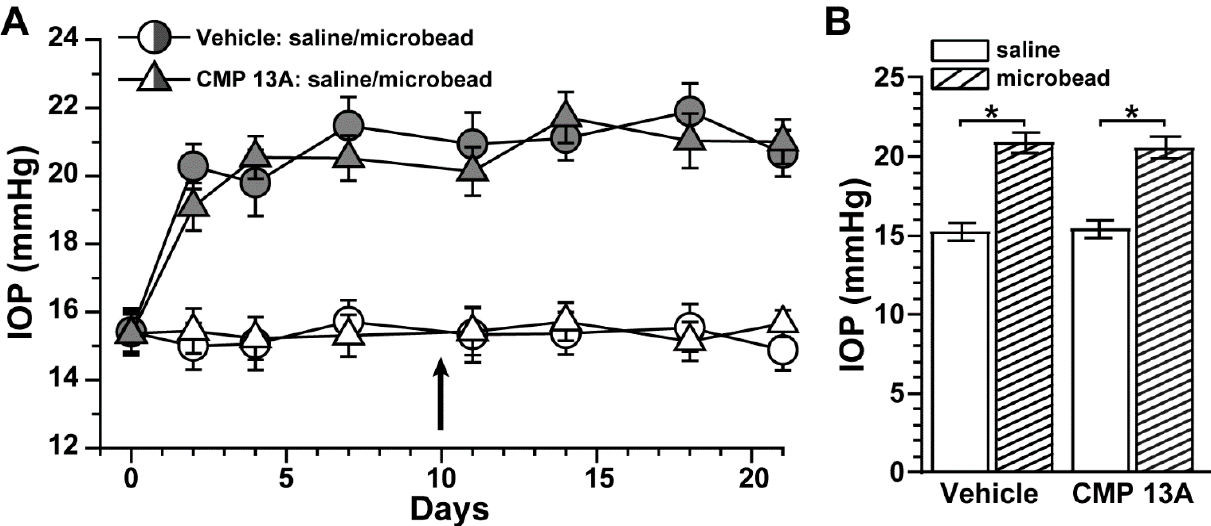
Figure 1. Collagen mimetic peptide does not influence IOP. ( A ) Mean daily intraocular pressure (IOP) in mice treated with vehicle ( ○ , n = 6) vs. CMP 13A ( Δ , n = 7) prior to (day 0) and following (days ≥ 1) a single unilateral injection of either polystyrene microbeads or an equivalent volume of saline in the contralateral eye; intravitreal injection of CMP or vehicle occurred on day 10. ( B ) Microbead injection significantly elevated IOP for both cohorts: vehicle (20.88 ± 0.67 vs. 15.27 ± 0.59 mmHg; *, p < 0.001); CMP 13A (20.58 ± 0.68 vs. 15.41 ± 10.57 mm Hg; *, p < 0.001). IOP did not differ between cohorts for either the saline- or microbead-injected eye ( p ≥ 0.33). Data = mean ± SEM.